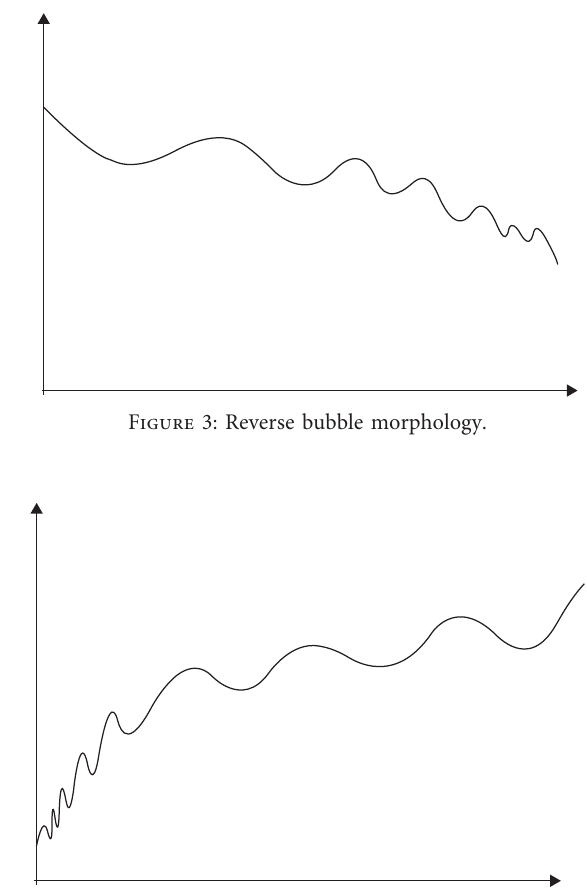
Figure 4: Reverse-negative bubble morphology.